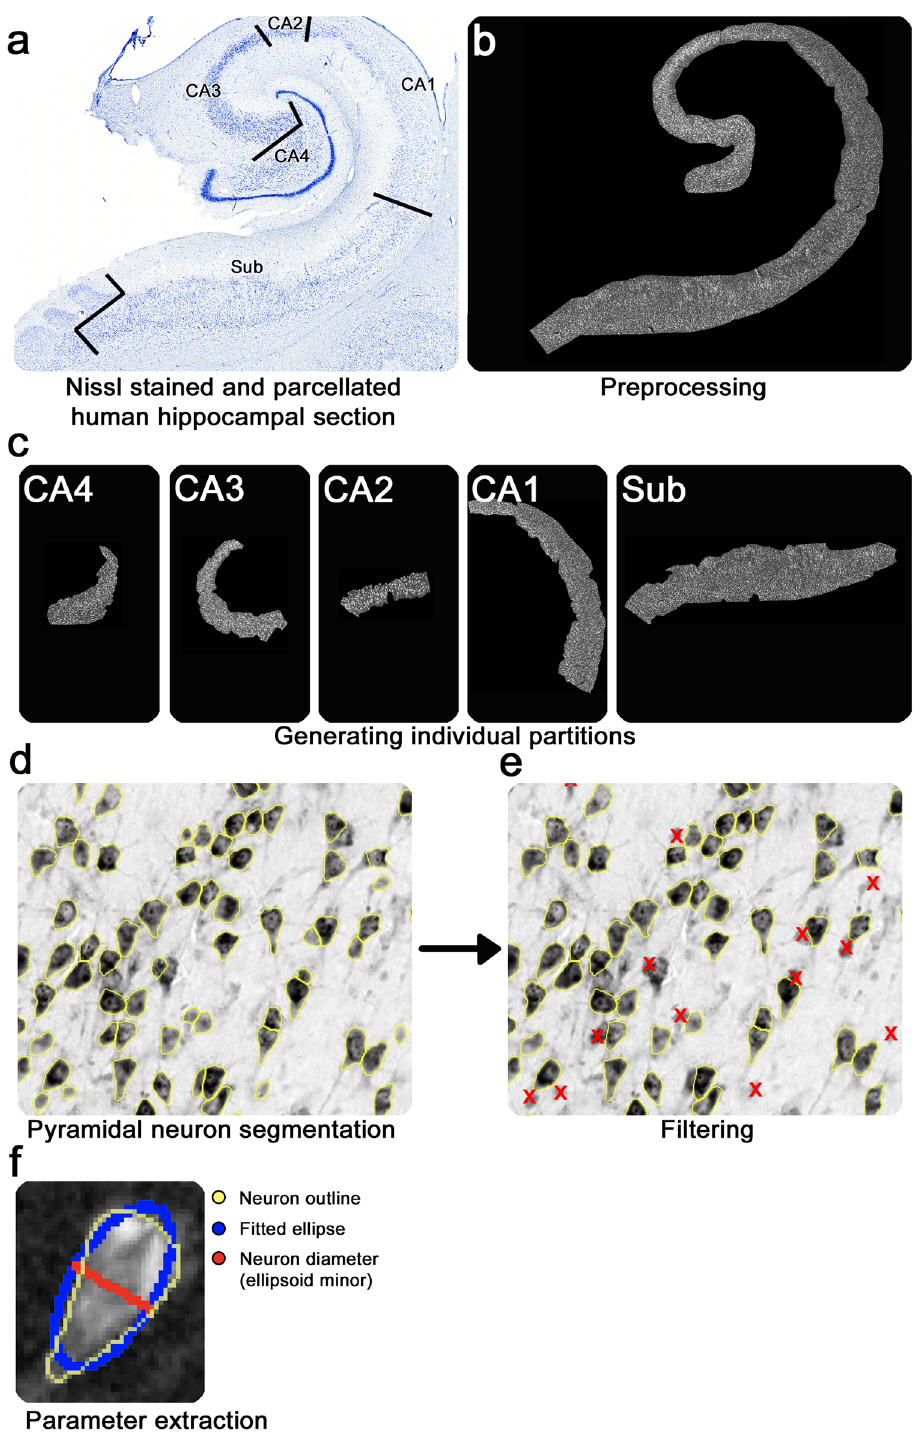
Figure 2. CellPose deep learning pipeline applied to hippocampal pyramidal neurons: ( a ) parcellated photomacrograph of hippocampus stained for Nissl substance (50 µm thick and coronal plane). ( b ) Cropped hippocampal pyramidal neuron layer to create partitions, transformed into inverted gray-value image. ( c ) Generating individual partitions. ( d ) Unfiltered segmented pyramidal neurons based on CellPose. Yellow outlines show neuron segmentations. ( e ) Filtered segmented neurons. Red X’s indicate removed items from segmentation (false-positives), ( f ) Hippocampal pyramidal neuron ellipsoid fitting and measurements (yellow: neuron segmentation, blue: fitted ellipse, red: neuron diameter (ellipsoid